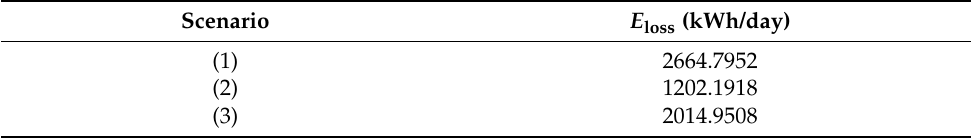
Table 7. Power losses for 69-node system scenarios.